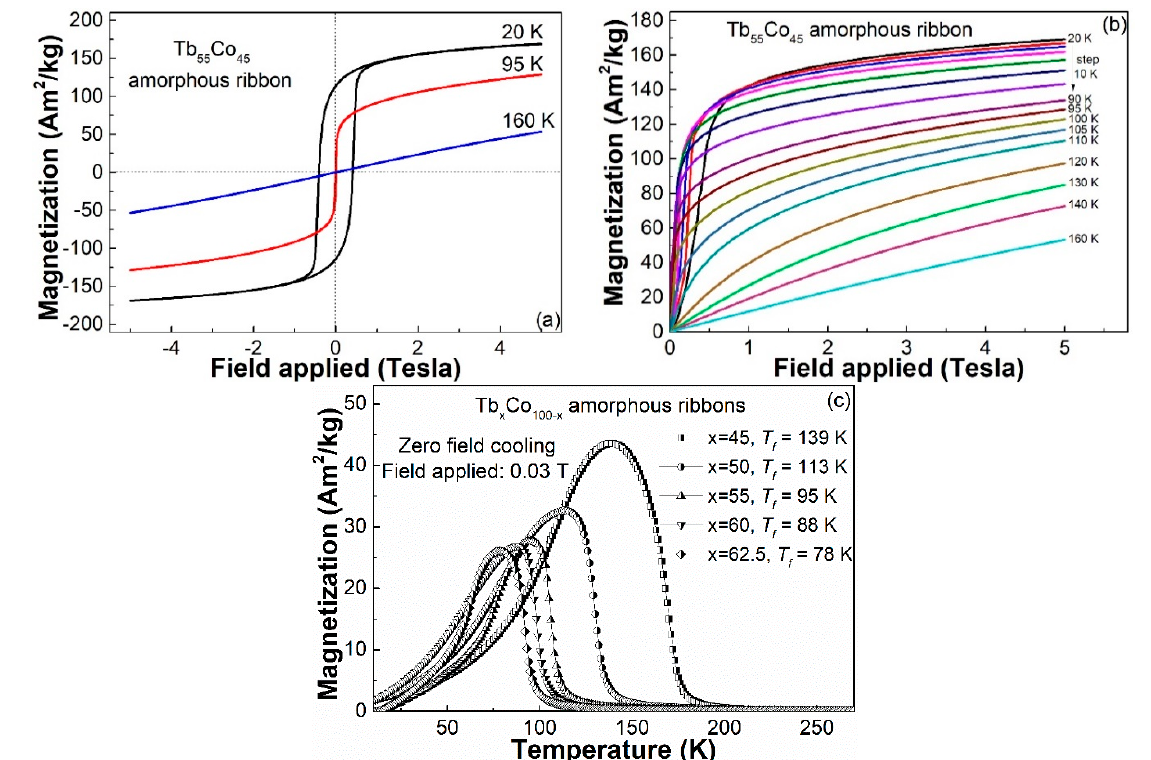
Figure 3. ( a ) The hysteresis loops and ( b ) the isothermal M – H curves of the Tb 55 Co 45 amorphous ribbon measured at different temperature under a magnetic field of 5 T; ( c ) zero field (ZFC) M–T curves of the Tb x Co 100 − x (x = 45, 50, 55, 60, 62.5) amorphous ribbons.